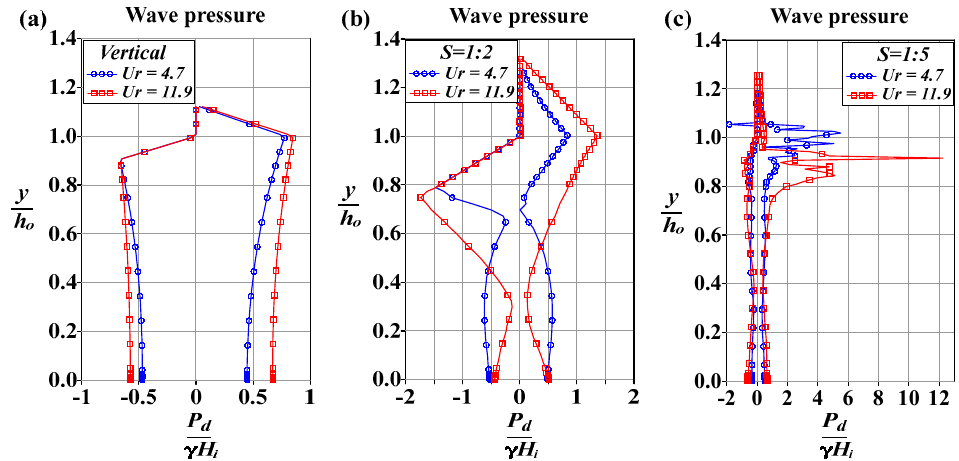
Figure 13. Comparison of the maximum wave pressure distributions with different Ursell numbers: Ur = 4.7 and Ur = 11.9, respectively. ( a ) Vertical wall (VW); ( b ) S = 1:2, sloping seawall; ( c ) S = 1:5, sloping seawall.